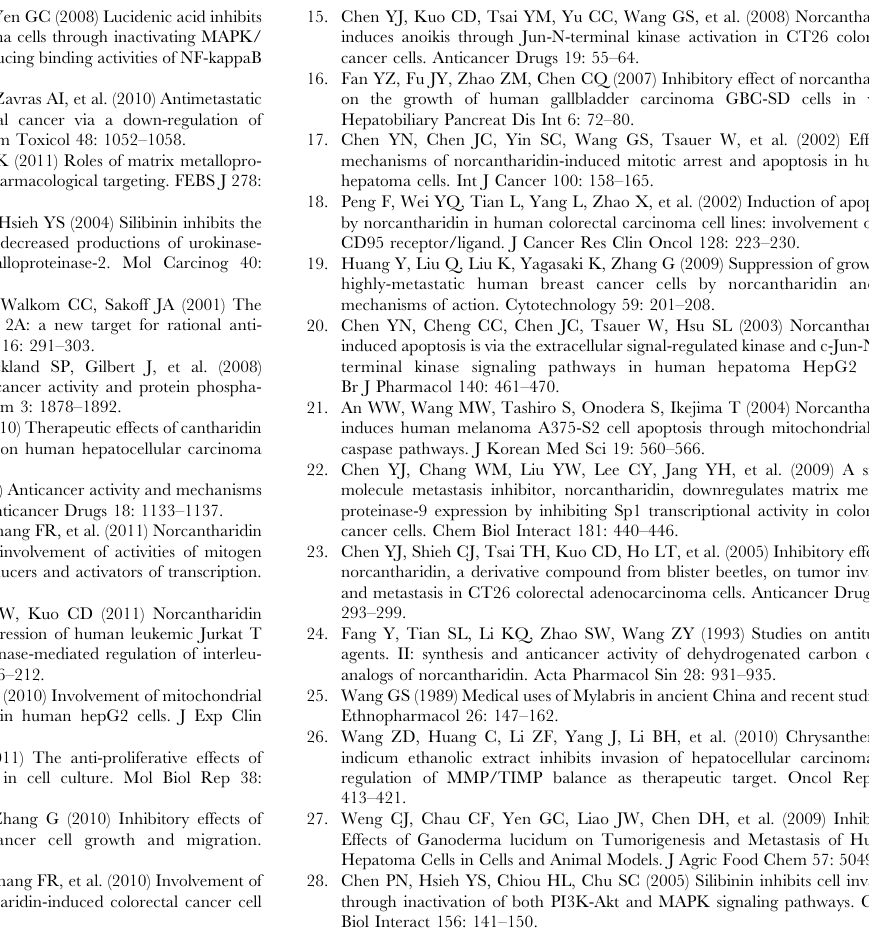
Figure S1 Effect of NCTD on cell viability in normal hepatocytes. Normal hepatocytes were treated with NCTD (0, 2.5, 5 and 10 m M) for 24 h before being subjected to a MTT assay for cell viability. The values represented the means 6 SD of at least three independent experiments. Figure S2 Effects of NCTD on the cell cycle regulation in Huh7 cells. Huh7 cells were treated with NCTD (0 , 10 m M) for 24 h and then subjected to flow cytometry to analyze the cell cycle regulation. Figure S3 Effects of NCTD on the cell migration in SK- Hep1 cells. SK-Hep1 cells were treated with NCTD (0 , 10 m M) for 24 h and then subjected to a Boyden chamber for 16 h with polycarbonate filters respectively. The migration abilities of SK- Hep1 cells were quantified by counting the number of cells that invaded to the underside of the porous polycarbonate as described in the Materials and Methods section. The values represented the